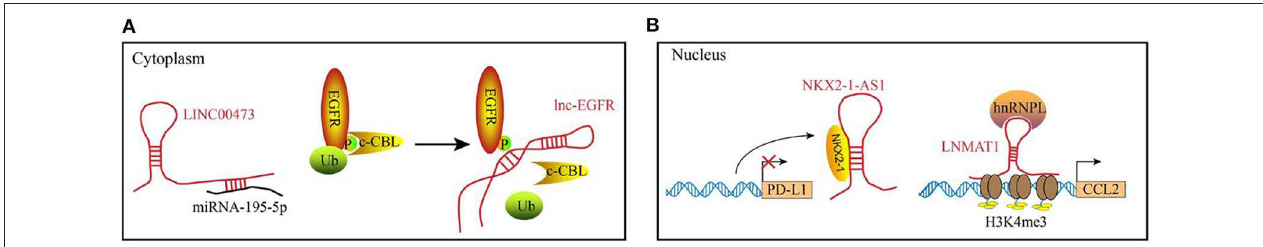
FIGURE 1 | Examples of the functional mechanisms for long non-coding (lncRNAs). LncRNAs function through interacting with diverse molecules in (A) the cytoplasm or (B) cell nucleus. (A) In the cytoplasm, lncRNAs can interact with RNAs or proteins. For example, LINC00473 sponges miRNA-195-5p to reduce its expression level. lnc-EGFR binds to the phosphorylated EGFR to block the ubiquitination, which maintains the activation of EGFR pathway. (B) In the nucleus, lncRNA can act as decoys (e.g., NKX2-1-AS1) or guides (e.g., LNMAT1) to regulate the gene expression at transcriptional levels.